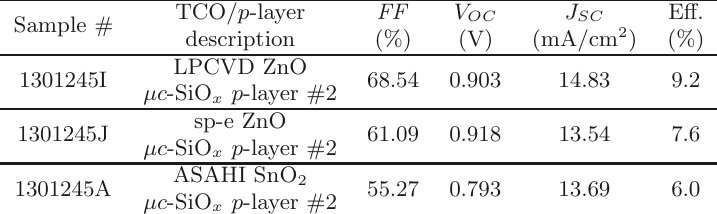
Table 2. Initial photovoltaic parameters of pm -Si:H p - i - n devices fabricated on three different TCO substrates. All the cells incorporate the same p- μ c -SiO:H, i-pm -Si:H (250 nm) and n- μ c -Si:H layers and sputtered ZnO-Ag back